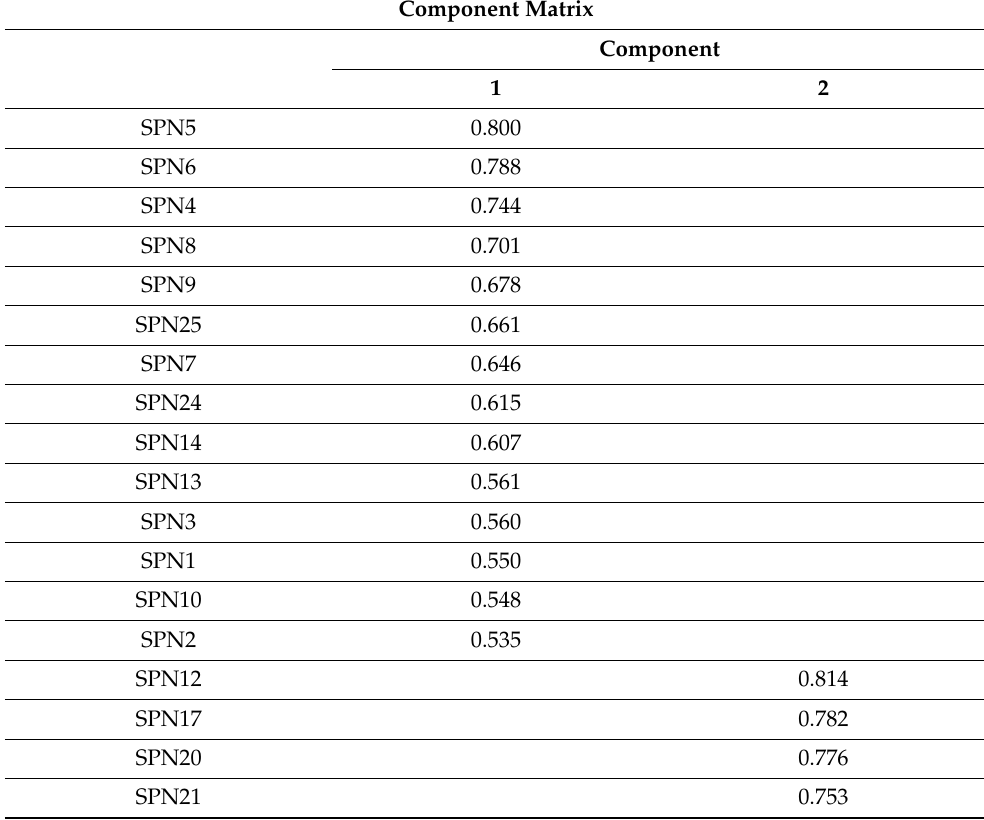
Table 5. Rotated component